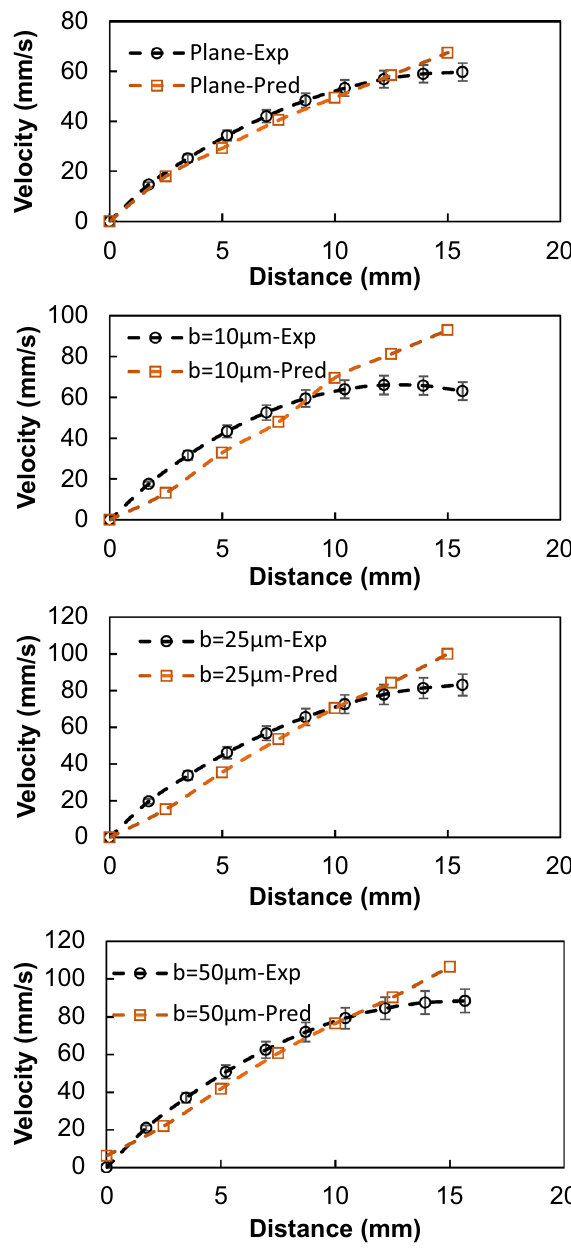
Figure 4. Comparison of droplet velocity obtained from experiments and analytical formulation for various gap spacings. Droplet size is 40 μL, inclination angle δ =